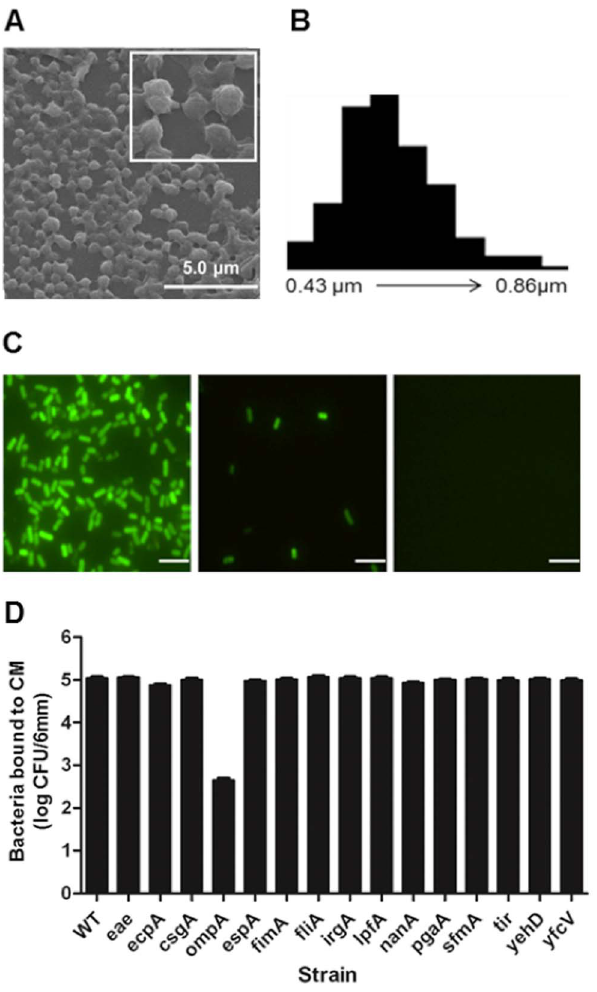
Figure 2. Identification of CM binding target using invitro CM binding assay. (A) Scanning electron microscopy micrograph of CM. Inset is magnified image of CM. (B) The distribution of particle size was determined by measuring the diameter of 200 particles using image J software. (C) In vitro binding assay of E. coli O157:H7. Bacteria cells carrying pEYFP grown in the presence of IPTG were harvested and incubated on CM-coated (left), poly-lysine-coated (middle), or no- coated slides (right). Bacteria in 6-mm wells were observed by fluorescence microscopy. Scale bars represent 5 m m. (D) Identification of CM binding target. E. coli O157:H7 strains were grown in broth and